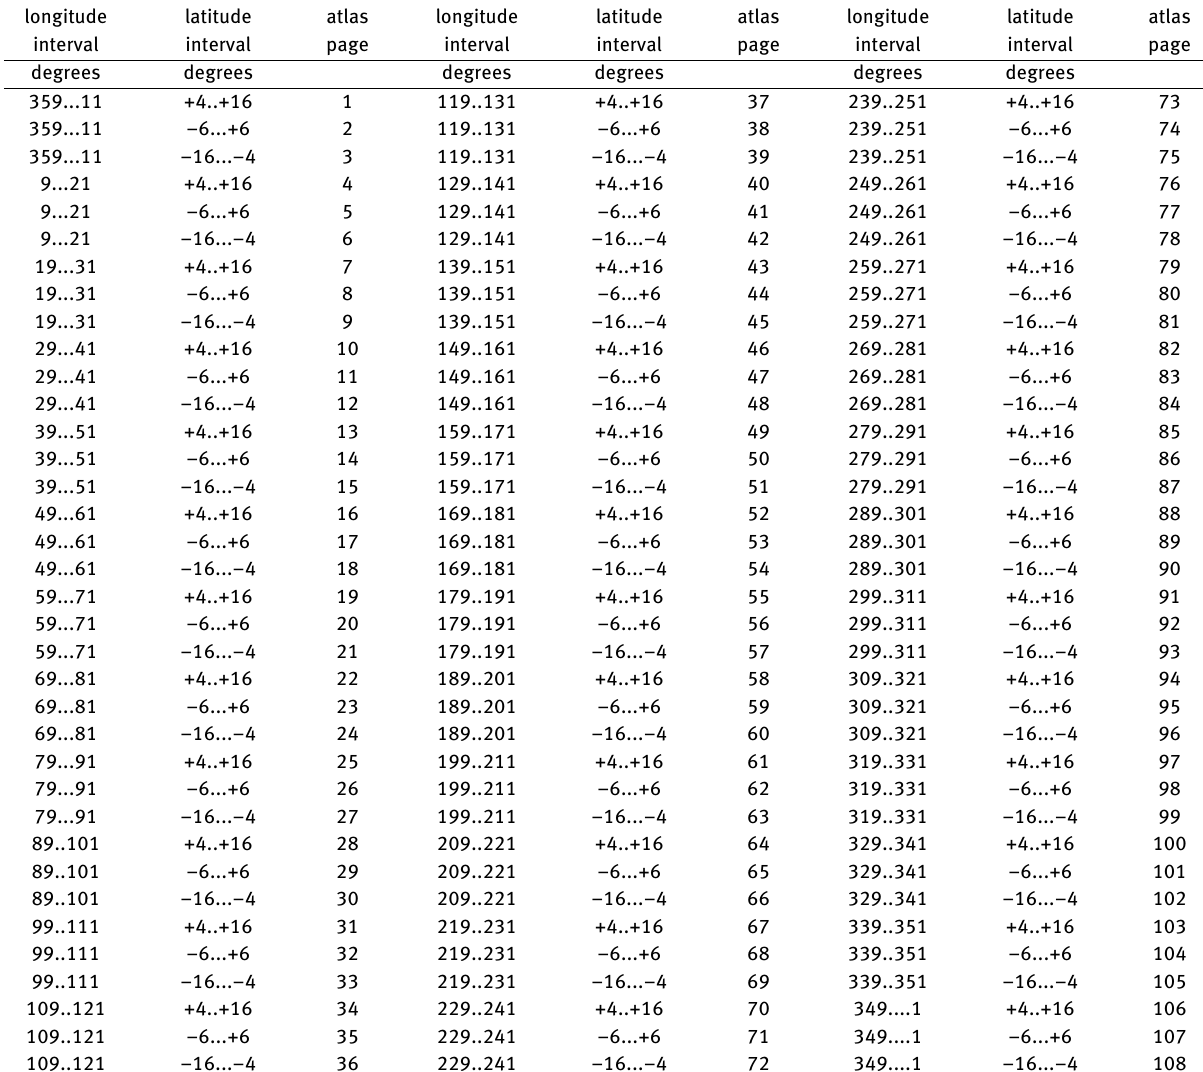
Table 1. The list of atlas pages and its correspondence to the galactic longitude and the galactic latitude